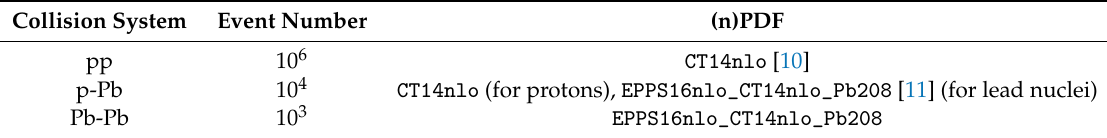
Table 1. The run setups and their main parameters.